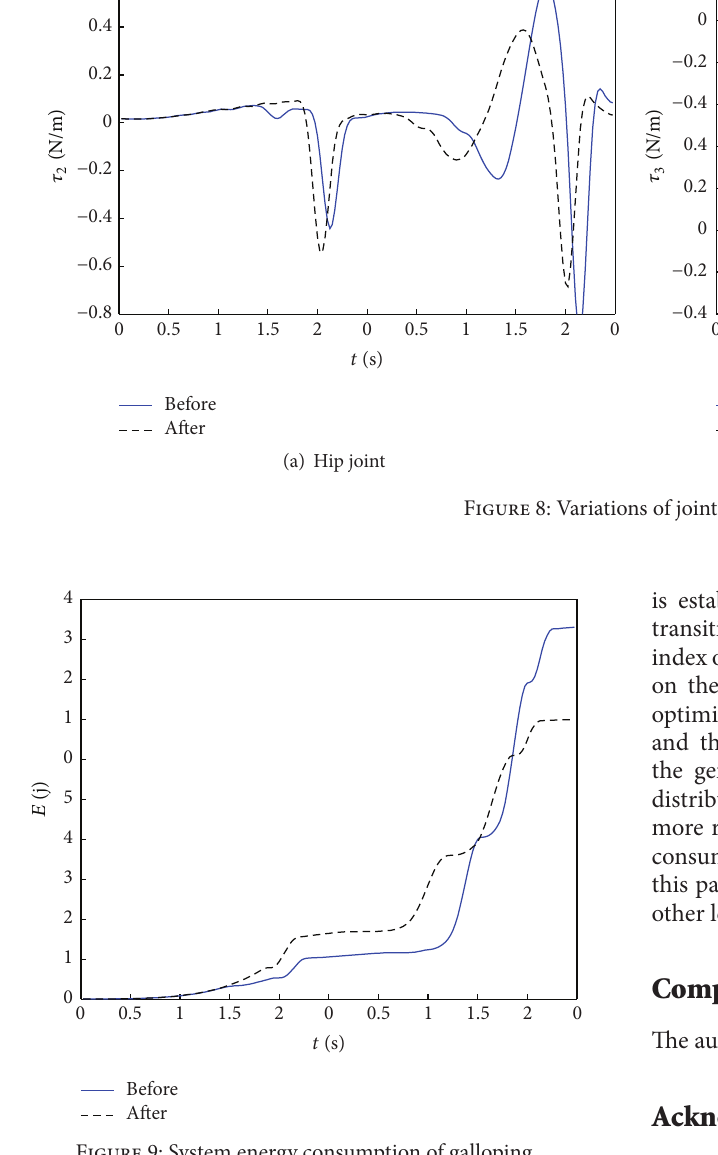
in the lift-off phase. After optimization, the system energy consumption is reduced by 23% in one gait period. It illustrates that the method of trajectory planning based on energy consumption optimization is reasonable and